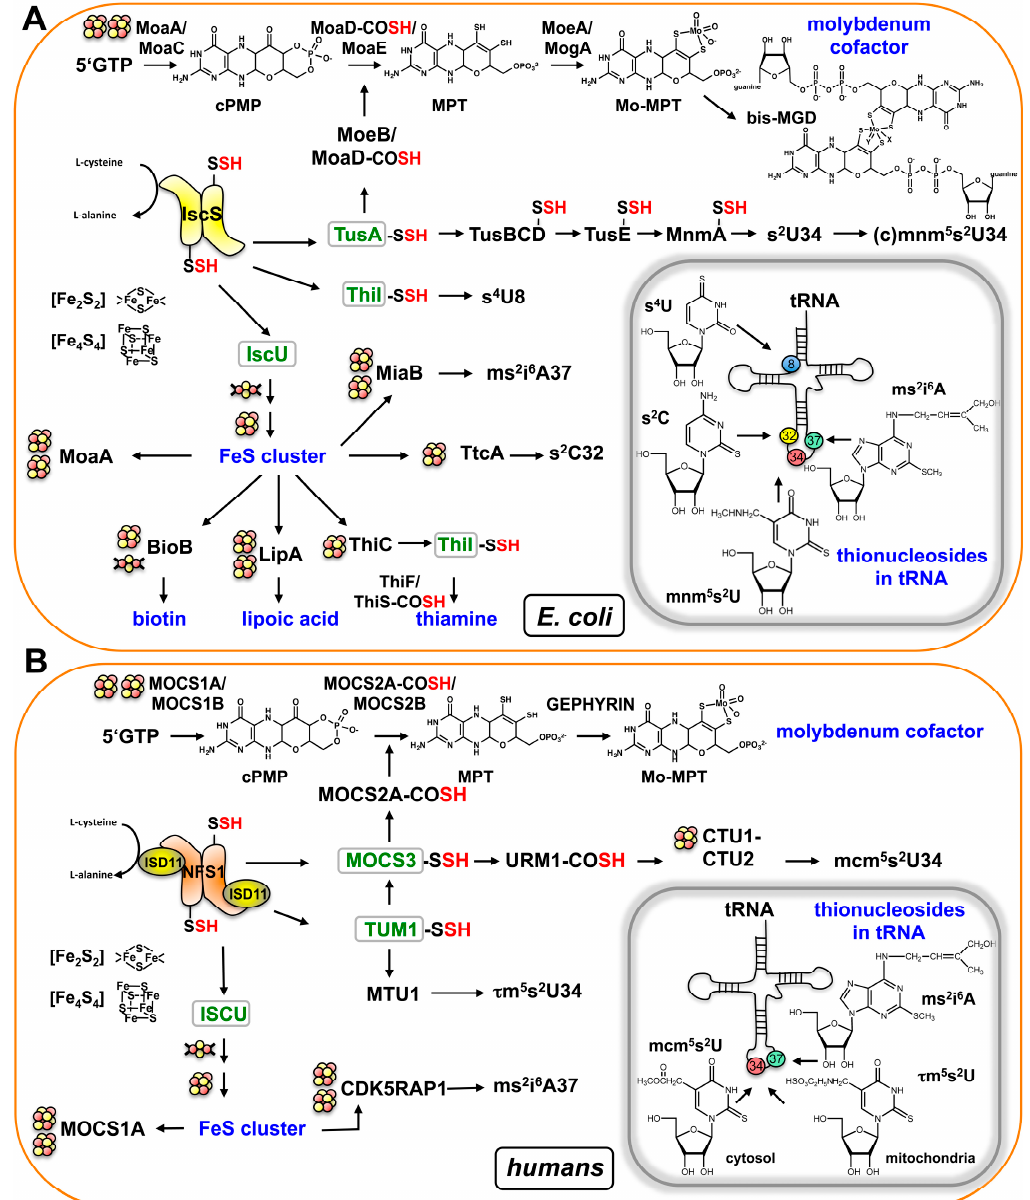
Figure 6. Sulfur transfer routes for the biosynthesis of sulfur ‐ containing molecules in E. coli ( A ) and humans ( B ). Detailed descriptions are given in the text. Acceptor proteins that receive the sulfur from the L ‐ cysteine desulfurase are marked in green. Proteins that contain FeS clusters are marked by one or two cluster symbols. The locations of the modified nucleosides in tRNA are shown in the inset boxes. –SSH: persulfide, –COSH: thiocarboxylate.